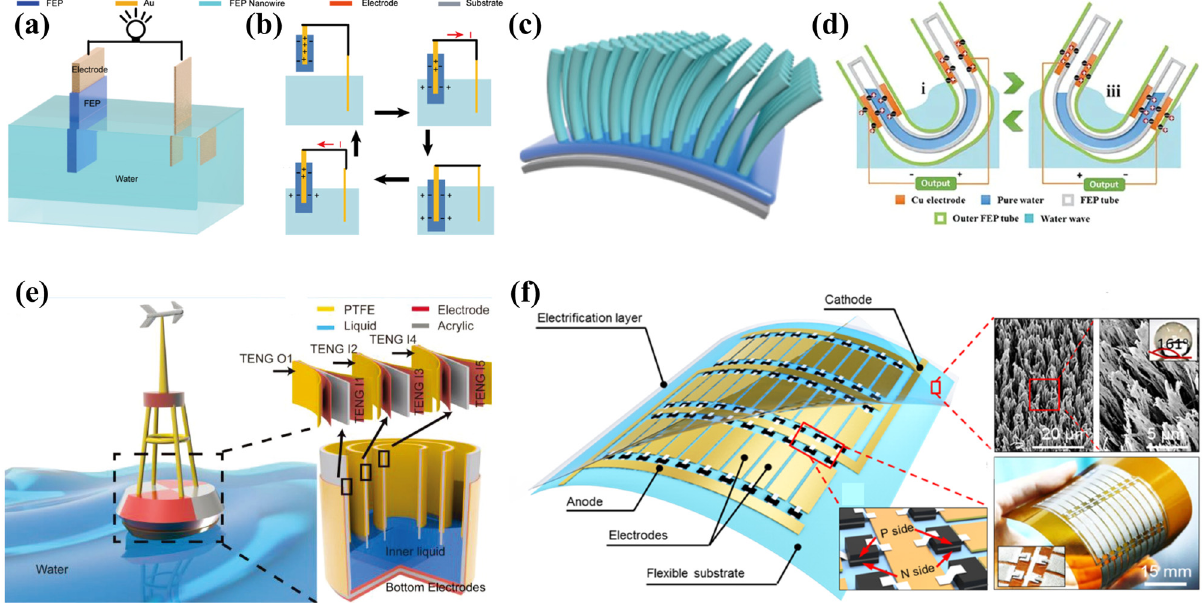
Figure 9: ( a and b ) The working principle of the nanowire - based TENG, ( c ) illustration of a bent nanowire - based [ 47 ] , ( d ) schematic illustration of the functional components of the U - tube TENG [ 77 ] , ( e ) the structure of a buoy nanogenerator [ 78 ] , and ( f ) structure of a networked integrated triboelectric nanogenerator ( NI - TENG ) [ 79 ]